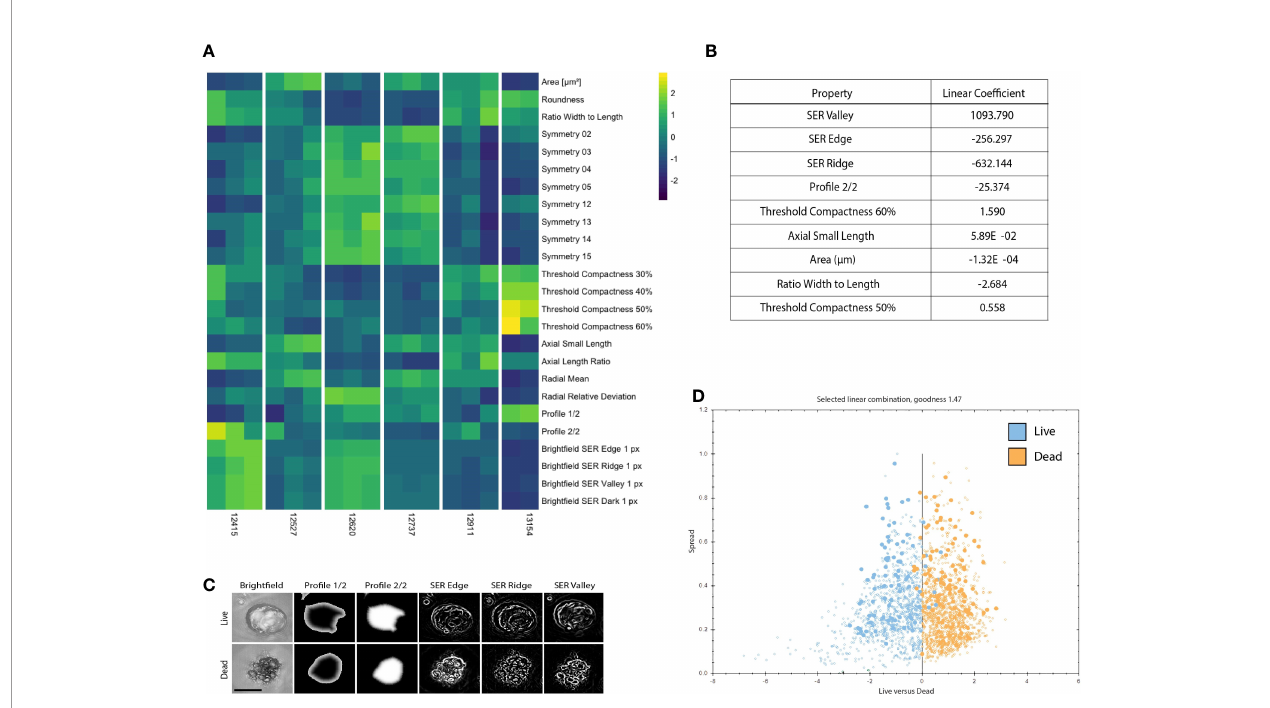
FIGURE 2 | PDOs display distinct texture and morphology features related to viability. (A) Heatmap illustrating 25 morphology and texture features (z-score normalized) across 6 different PDOs in the untreated (media only) condition on Day 3. Columns represent replicates for each PDO. (B) Features discriminating between live and dead PDOs are listed in order of relevance as indicated by the linear coef fi cient. (C) Representative PDO images of selected morphology and texture features that discriminate between live and dead classi fi cation. Scale bar is 50 m m. (D) The signal to noise ratio is displayed as goodness of live (blue) versus dead (orange) PDOs manually classi fi ed in the training set. Filled circles denote PDOs included in the training set and open circles are classi fi ed by the